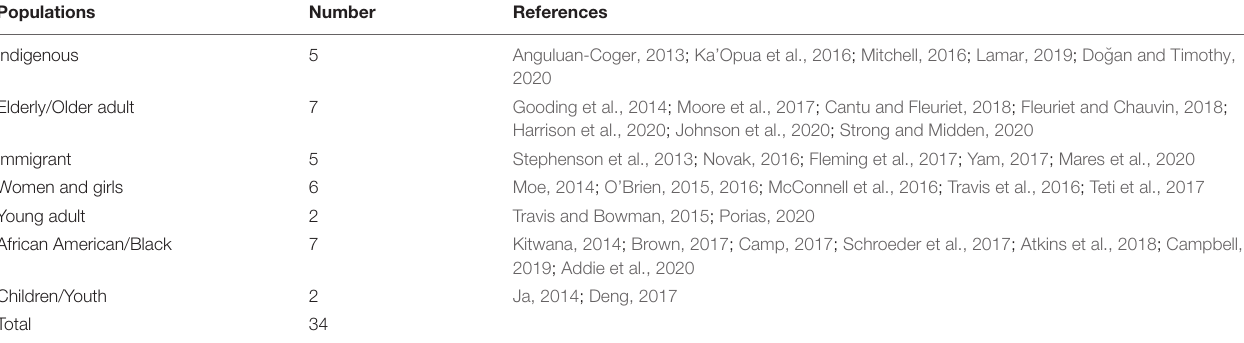
TABLE 1 | Marginalized